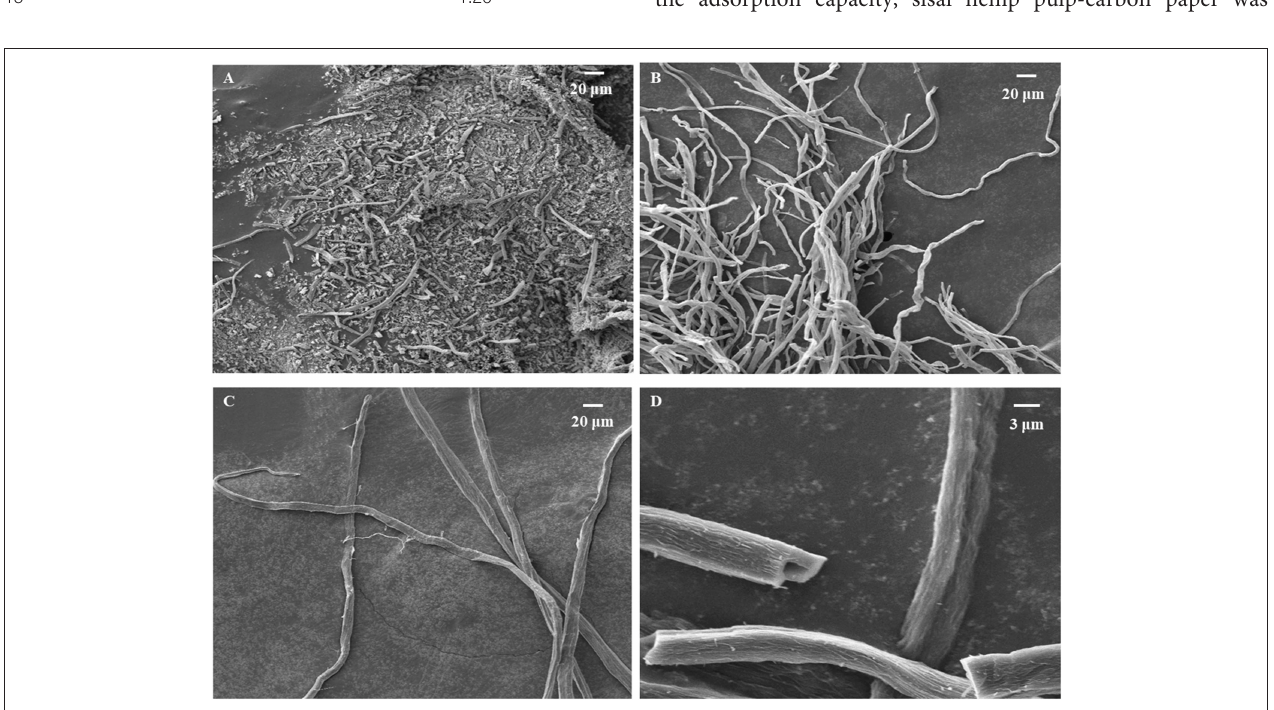
FIGURE 4 | SEM images of carbonized sisal hemp pulp-based paper at 900 ◦ C (A) , 800 ◦ C (B) , and 700 ◦ C (C) and a magnified image of 700 ◦ C (D) .